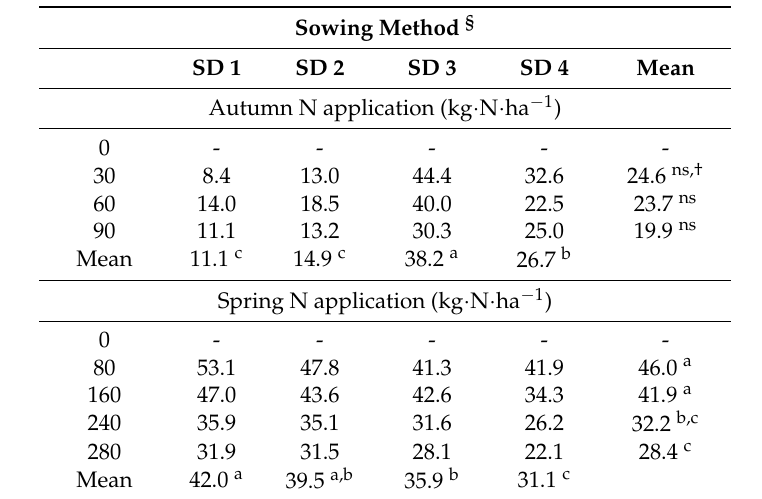
Table 4. Sowing method by N application interaction effects on apparent N use efficiency (%) (2009/2010, 2010/2011,